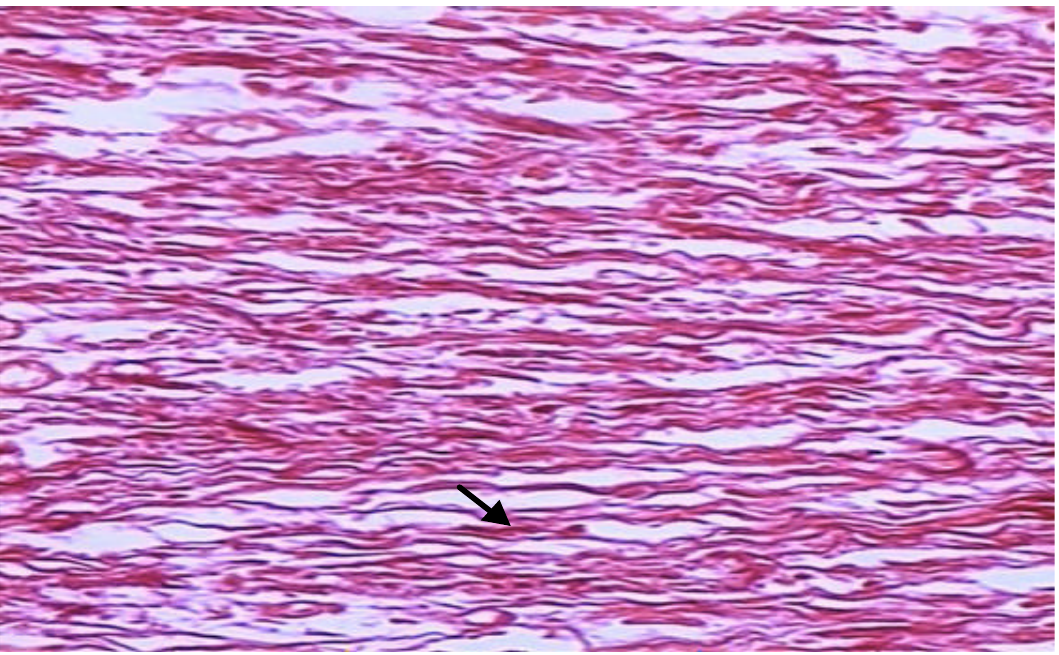
FIGURA 9 – Fotomicrografia de corte histológico da zona de anastomose jujuno-jejunal de coelho do sub-grupo Af (adesivo biológico – 2 pontos) no 14º dia de pós- operatório. Notar a quantidade de fibras colágenas (seta). Picrosirius Red